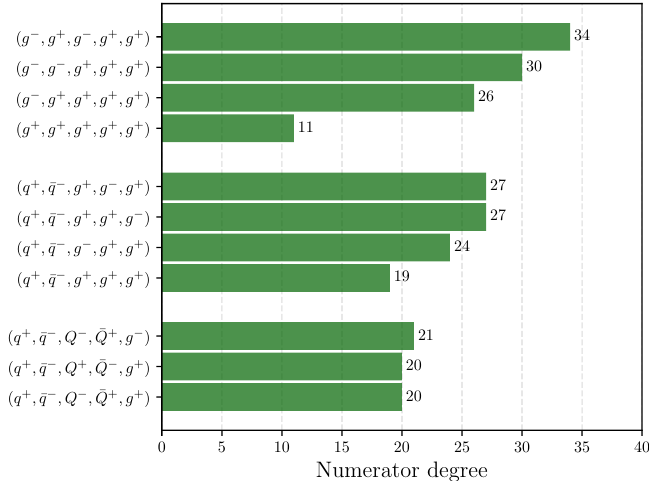
Figure 8 . Maximal degrees of numerators of N 0